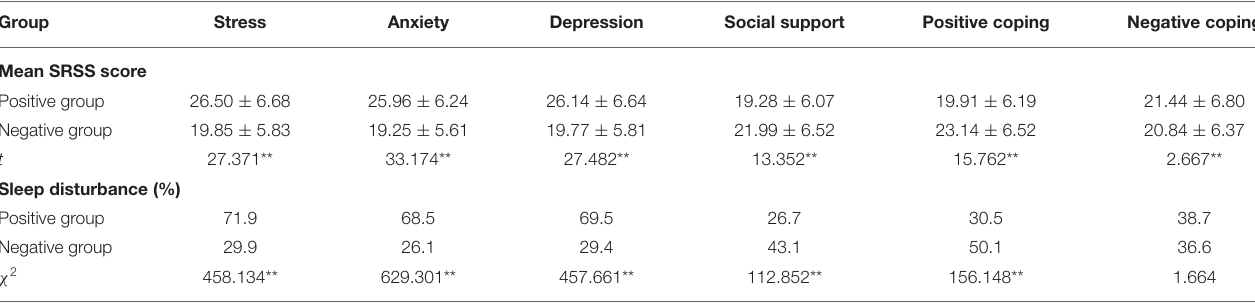
TABLE 5 | Comparison of SRSS scores and prevalence rates of sleep disturbance among groups with positive or negative stress, anxiety, depression, social support, or positive/negative coping. Group Stress Anxiety Depression